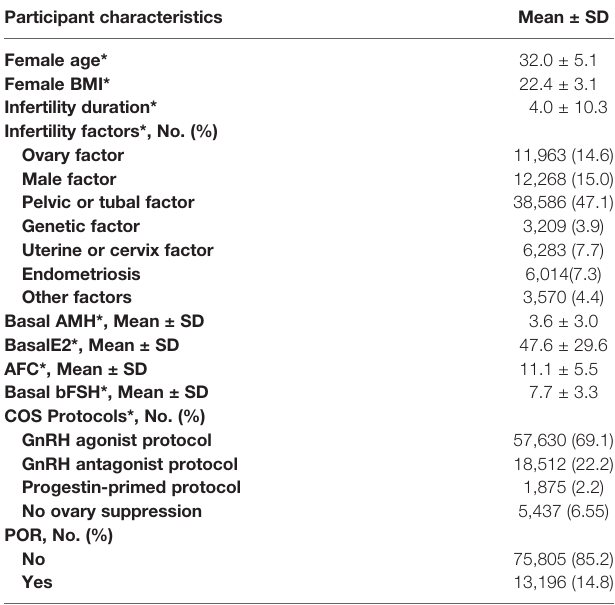
TABLE 1 | Baseline characteristics and treatment outcome of the 89,001 women in the study group.